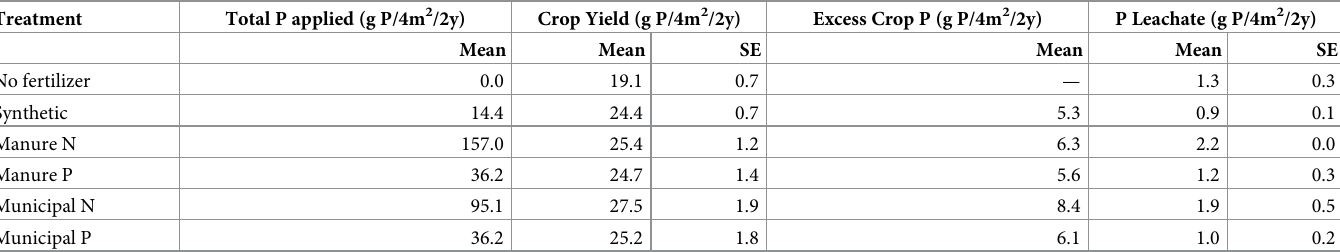
Table 3. Mean mass of P applied to 4m 2 plot over two years, P recovered from crop yield, and P recovered from crops in excess of control treatment mean. Treatment